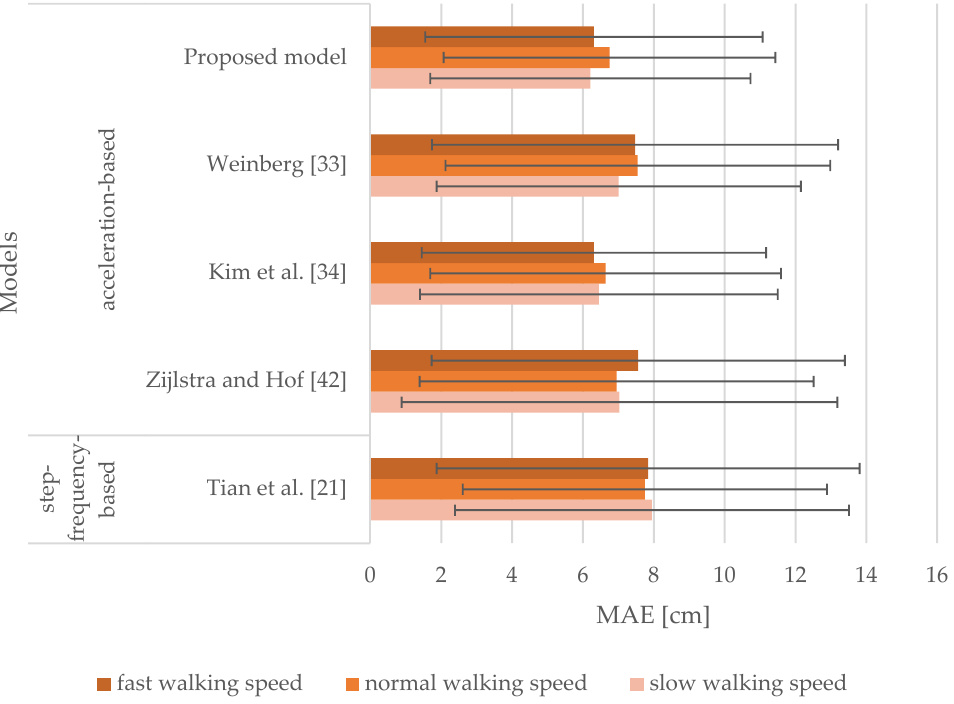
Figure 9. MAEs and SDs of the models for the smartphone attached to the thigh for slow, normal, and fast walking speeds. Table 3. MAEs and SDs of walked distances estimated by the selected models for smartphones attached to the upper arm, hand, pelvis, and